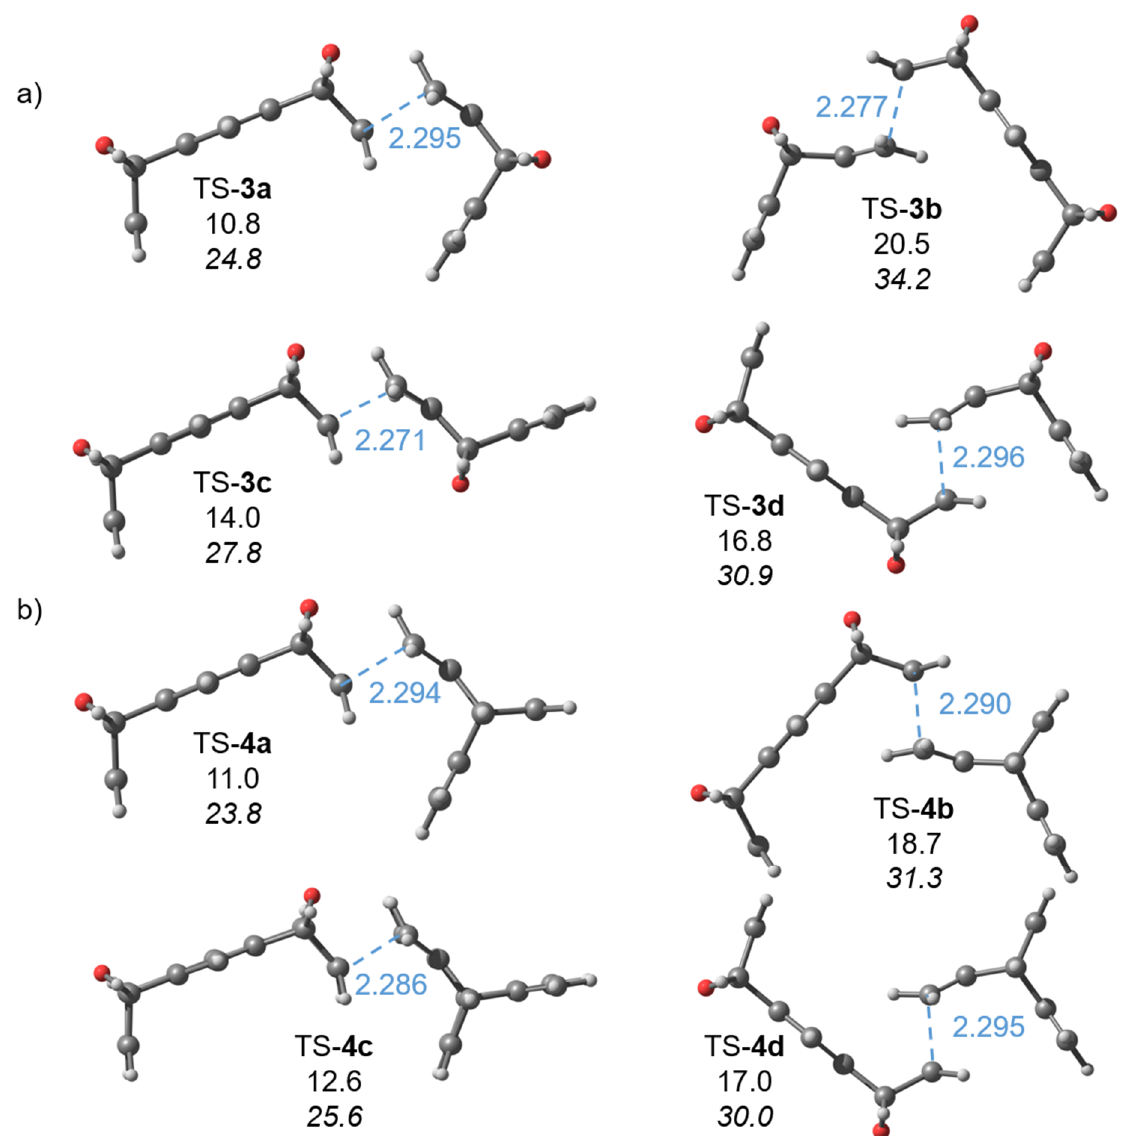
Figure 1. Lowest energy transition states for the formation of diastereomers 3 ( a ) and 4 ( b ) as computed at the M062X/6- 311+G**/toluene level of theory. Distances between reacting carbon atoms are given in Å (blue), enthalpies (normal print), and free energies (italics) at 298.15 K are given in kcal mol − 1 . Note that for the formation of each diastereomer, there is another transition state that is higher in energy and that is not depicted for clarity: Red, oxygen; dark gray, carbon; light gray,